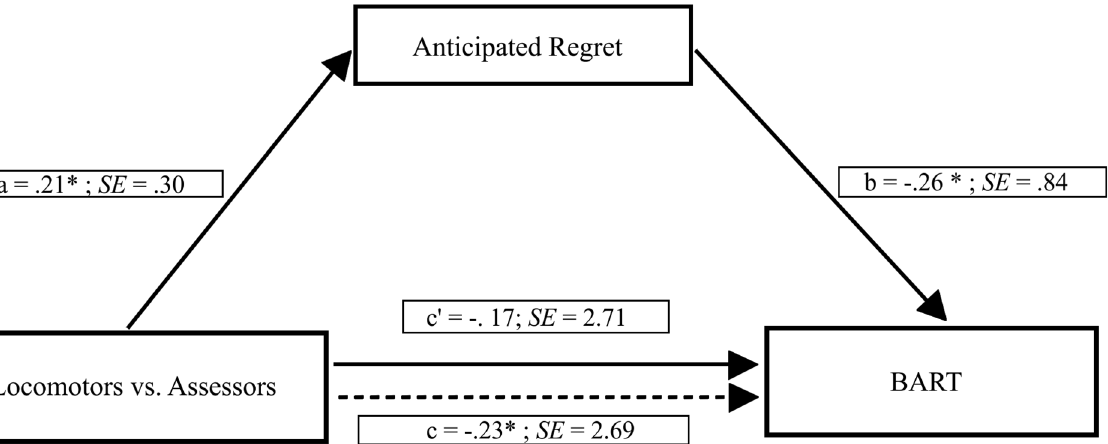
Fig 1. Mediation model showing the effect of experimentally induced locomotion orientation – compared to assessment orientation – on risk-taking through anticipated regret. Path values represent standardized regression coefficients. The (c') value represents the effect, from bootstrapping analyses, of experimentally induced regulatory mode on risk-taking after the mediator is included. Dotted line (c) represents the effect of experimentally induced regulatory mode on risk-taking prior to the inclusion of anticipated regret. * p < .05; ** p <